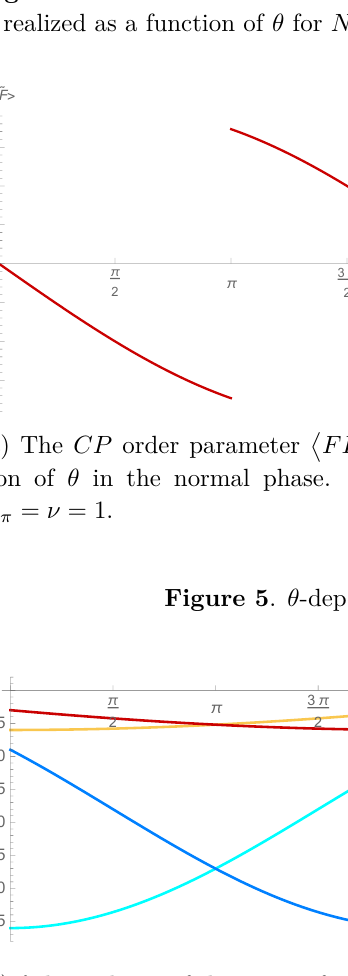
(b) Normalized critical chemical poten- tial ( m = ν = 1 ) above which the su- π perfluid phase is realized as a function of θ .